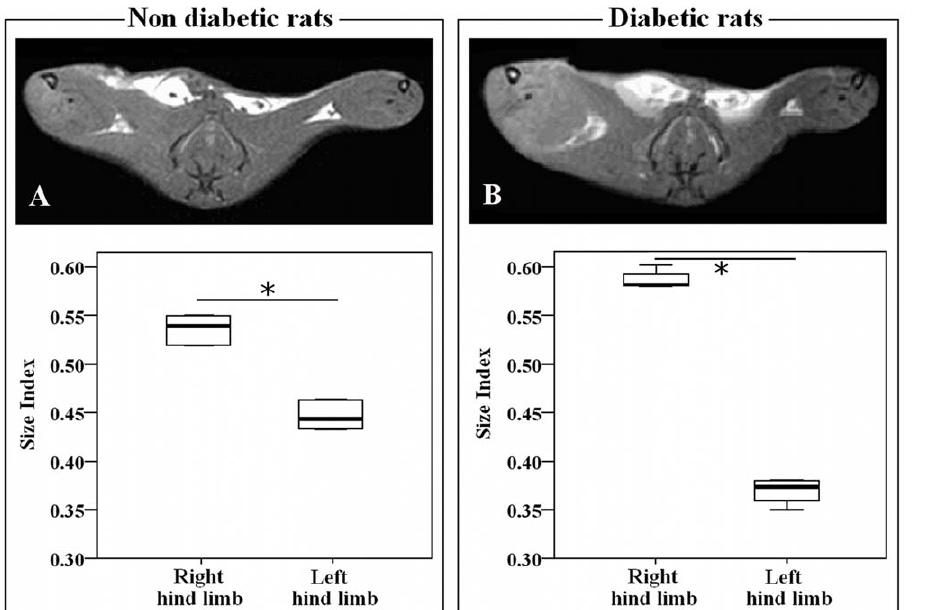
Figure 4. Representative T 1 -W images of the occluded and non-occluded hind limbs and morphometric outcomes. Left and right panels are referred to non-diabetic and a diabetic rat, respectively. Axial T 1 -W images show increase in soft tissue size due to regional swelling after right common iliac-femoral artery ligation in both non-diabetic (A) and diabetic (B) rat. Box and Whiskers Plots show the distribution of size indices of occluded [size index=right limb area/(right limb area + left limb area)] and of non-occluded limb [size index=left limb area/(right limb area + left limb area)]. Statistically significant differences were noted comparing the size index of occluded and non-occluded limb both in diabetic (n=7) and non- diabetic (n=6) rats. Significance level: * p , 0.05. Box and Whiskers plot legend: the bottom and top of the box represent respectively the lower and